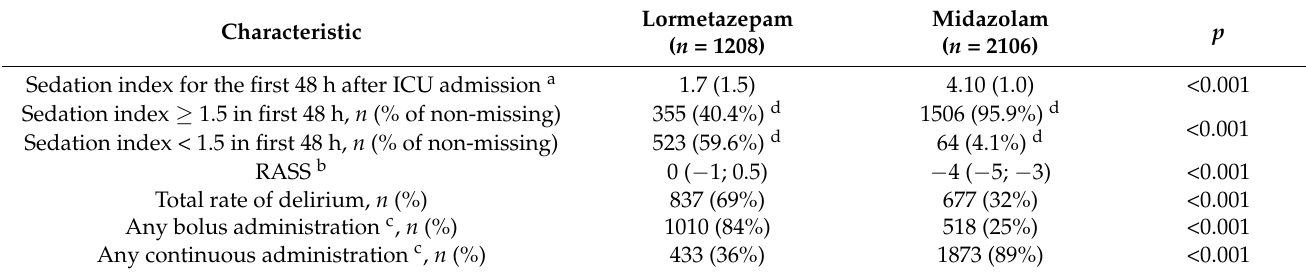
Table 2. Sedation-related characteristics of patients in the midazolam group and lormetazepam group. Characteristic